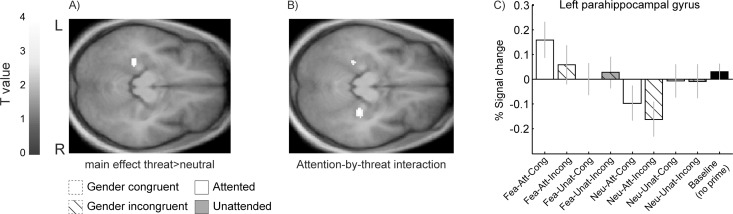
Effect of temporal attention on fearful primes.(A) Group-level contrast map (p<0.001 uncorrected) showing greater responses in left parahippocampal gyrus on trials with fearful prime (vs neutral). (B) Contrast map and (C) group parameter estimates illustrating the attention-by-emotion interaction in bilateral parahippocampal gyrus, indicating that temporal attention specifically enhanced the processing of fearful primes relative to neutral or unattended primes (same conventions as in Fig 3).